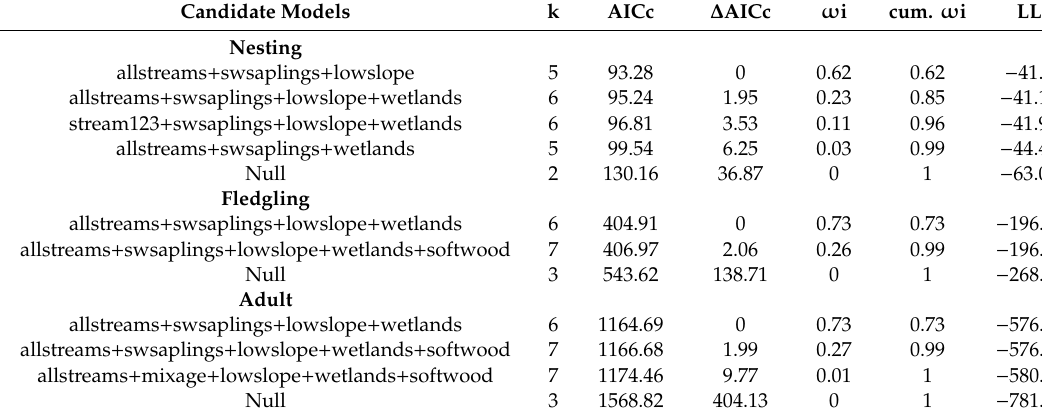
Table 2. High ranking candidate models for rusty blackbird nesting , fledgling , and adult habitat selection in Northern New Hampshire from 2010 − 2012. k = number parameters, AICc = Akaike information criterion for small sample sizes, ∆ AICc is the di ff erence between the model and top model, ω i = weight, cum., ω i = cumulative weight, and LL = log likelihood. See Table 1 for variable